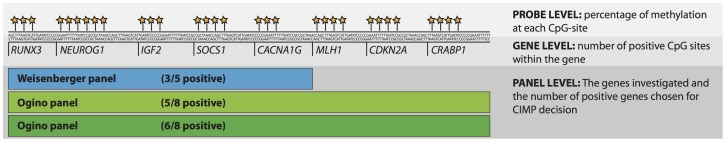
Illustration of the three levels of scoring, the panels and genes, and number of probes investigated in the presented study.